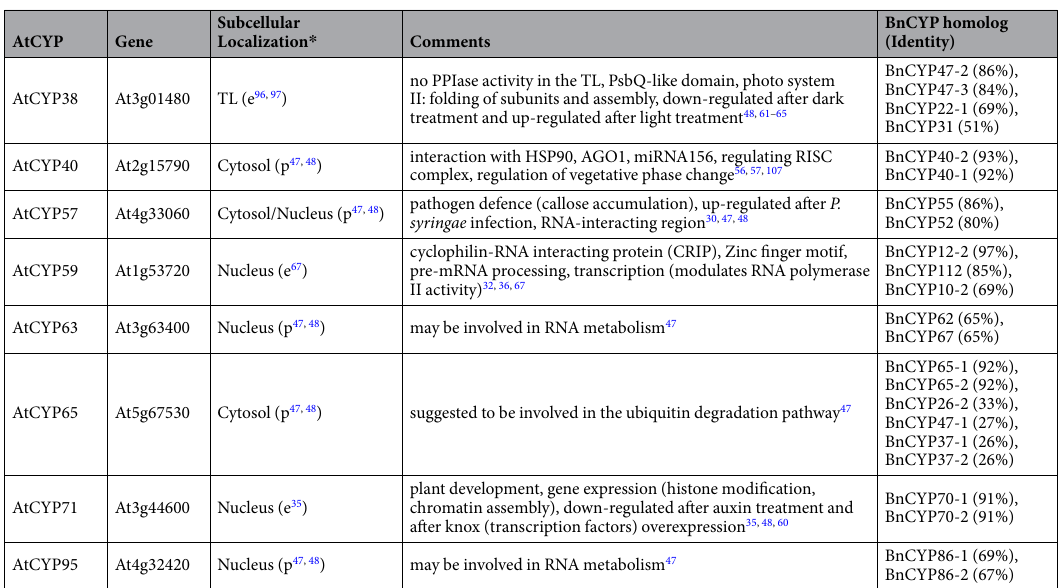
Table 2. The Arabidopsis cyclophilin family, localization, functions and corresponding Brassica homologs. * Localization was either p = predicted (SP, secretory pathway; TL, thylakoid lumen) or e = experimentally proven as described in the